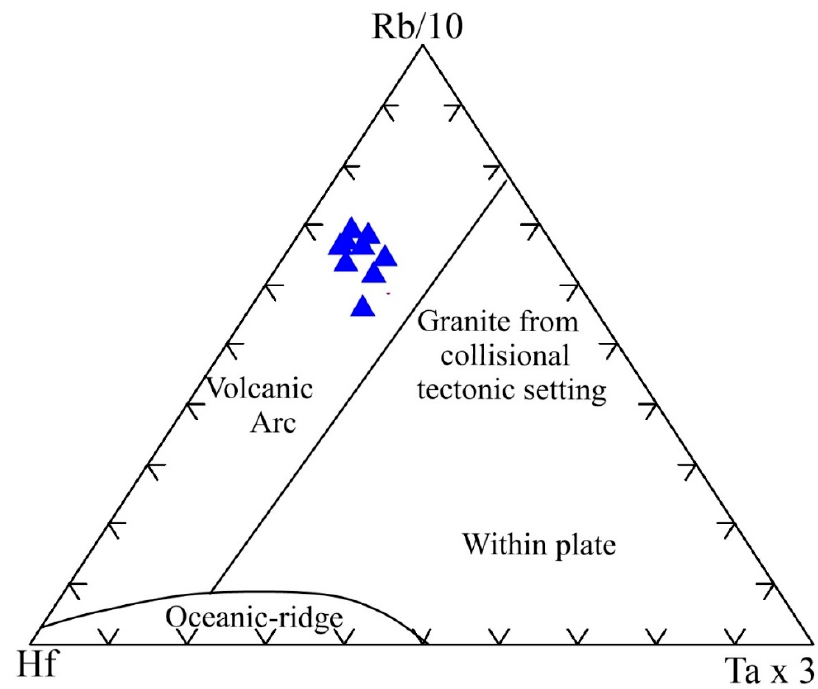
Figure 9. Rb/10 ‐ Hf ‐ Ta x 3 discrimination diagram [67], identifying tectonic setting .